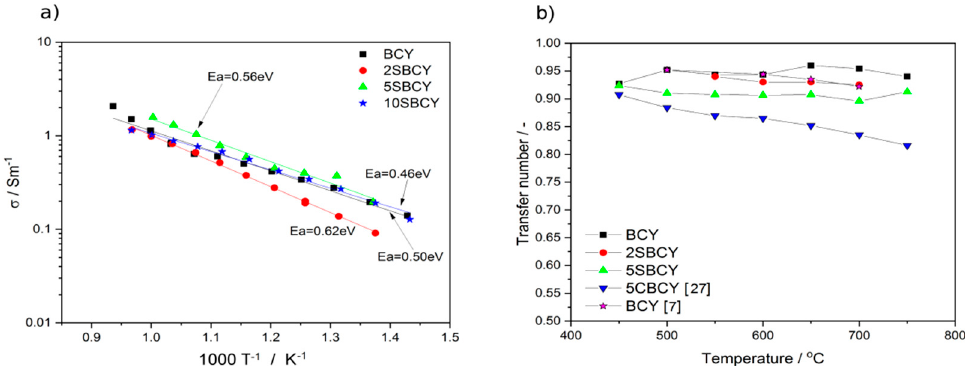
Figure 11. Independence of total electrical conductivity σ for SBCY sample series vs temperature recorded in H 2 O-5 vol.% H 2 in Ar ( a ); variation in the t ion transference number of BCY and 5SBCY ceramics determined by means of EMF measurements of a hydrogen concentration cell ( b